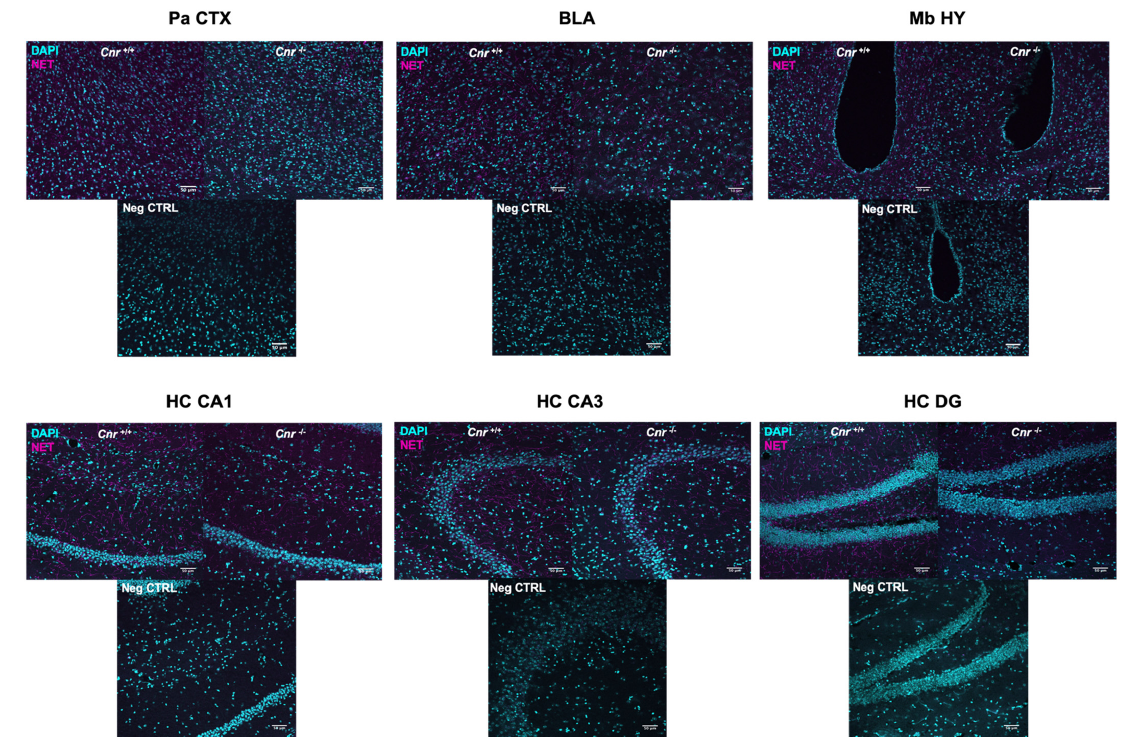
Figure 3. Representative photomicrograph of norepinephrine transporter (NET) staining within the parietal cortex (Pa CTX), basolateral amygdala (BLA), mediobasal hypothalamus (Mb HY) and hippocampal cornu ammonis 1 (CA1), cornu ammonis 3 (CA3), and dentate gyrus (DG) regions of 18-month-old wild-type (left) and Cnr1 − / − (right) animals. Negative controls (Neg CTRL)were stained only with the secondary antibodies. Scalebar: 50 µM. Int. J. Mol. Sci. 2020 , 21 , x FOR PEER REVIEW Our data show that the area covered by NET-positive signal was significantly lower in 18-month-old Cnr1 − / − mice (genotype effect: F (1,15) = 8.104; p = 0.0122) in all the target regions (region x genotype interaction F (5,750) = 0.6898; p = 0.6327) (Figure 4).